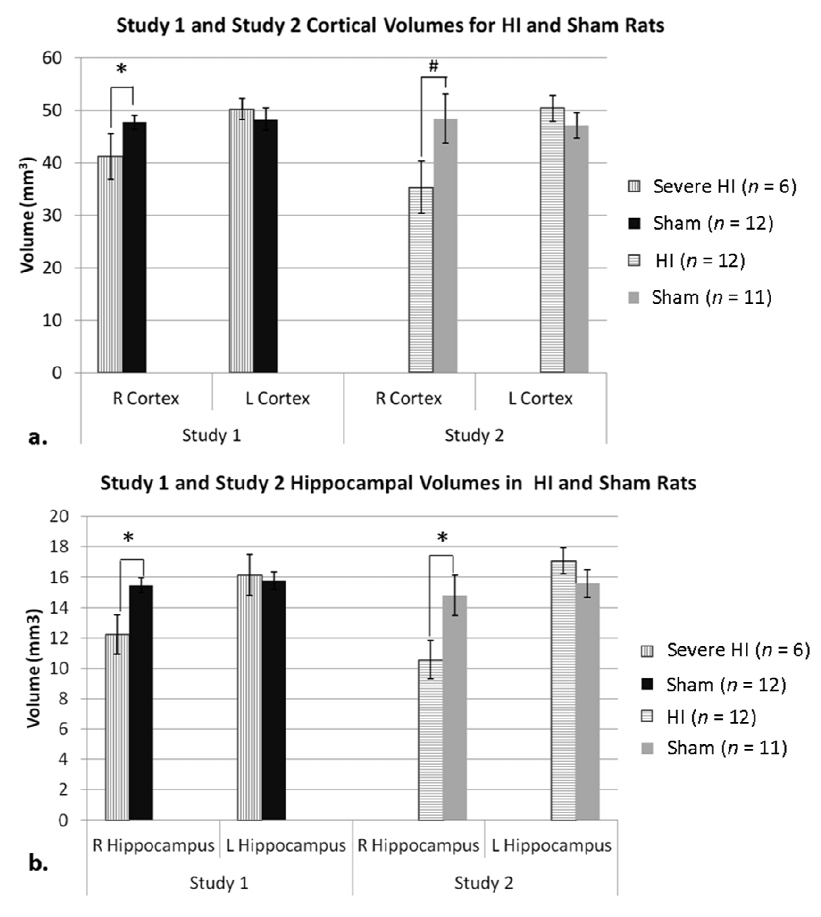
Figure 2. ( a ) As expected in Study 1 (since the Severe HI subset was selected for cortical atrophy), a t -test on right cortical volume revealed a significant effect of Treatment (* p < 0.05, Severe HI smaller than sham). For Study 2, an ANOVA comparing HI and sham animals revealed a Hemisphere × Treatment interaction, and a t -test also showed a trend (# p = 0.07) for HI to have smaller right cortical volume. Analysis of right cortical volume across Study confirmed a robust overall HI effect ( p < 0.05) and a lack of between-study differences. ( b ) For Study 1, an ANOVA comparing hippocampal volumes in severe HI and sham animals revealed an overall Treatment effect ( p = 0.05). A t -test comparing right hippocampal volume in both groups in Study 1 revealed a significant effect of Treatment (* p < 0.05), as was seen in Study 2 (* p < 0.05; HI smaller than sham). Analysis of right hippocampal volume across Study confirmed a robust overall HI effect ( p < 0.005), and a lack of between-study